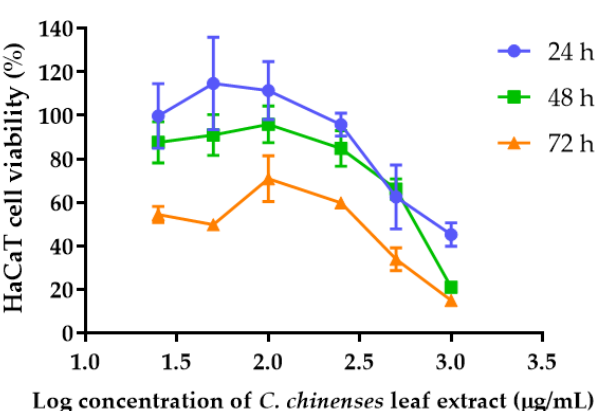
Figure 4. Effect of C. chinense leaf extract on HaCaT cell viability after incubation for 24, 48 and 72 h. Data are shown as the mean ± SD ( n = 3).